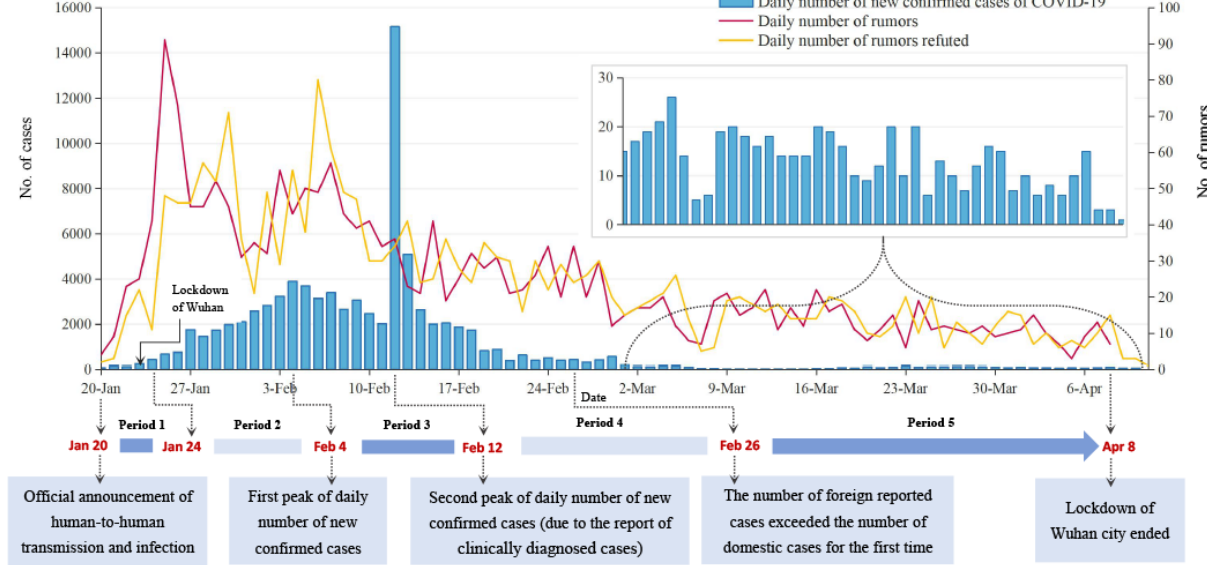
Figure 2. Daily numbers of rumors detected and refuted, the epidemic curve, and key events across five periods of the COVID-19 outbreak in China. The inset shows a magnified view of the number of COVID-19 cases over the last two